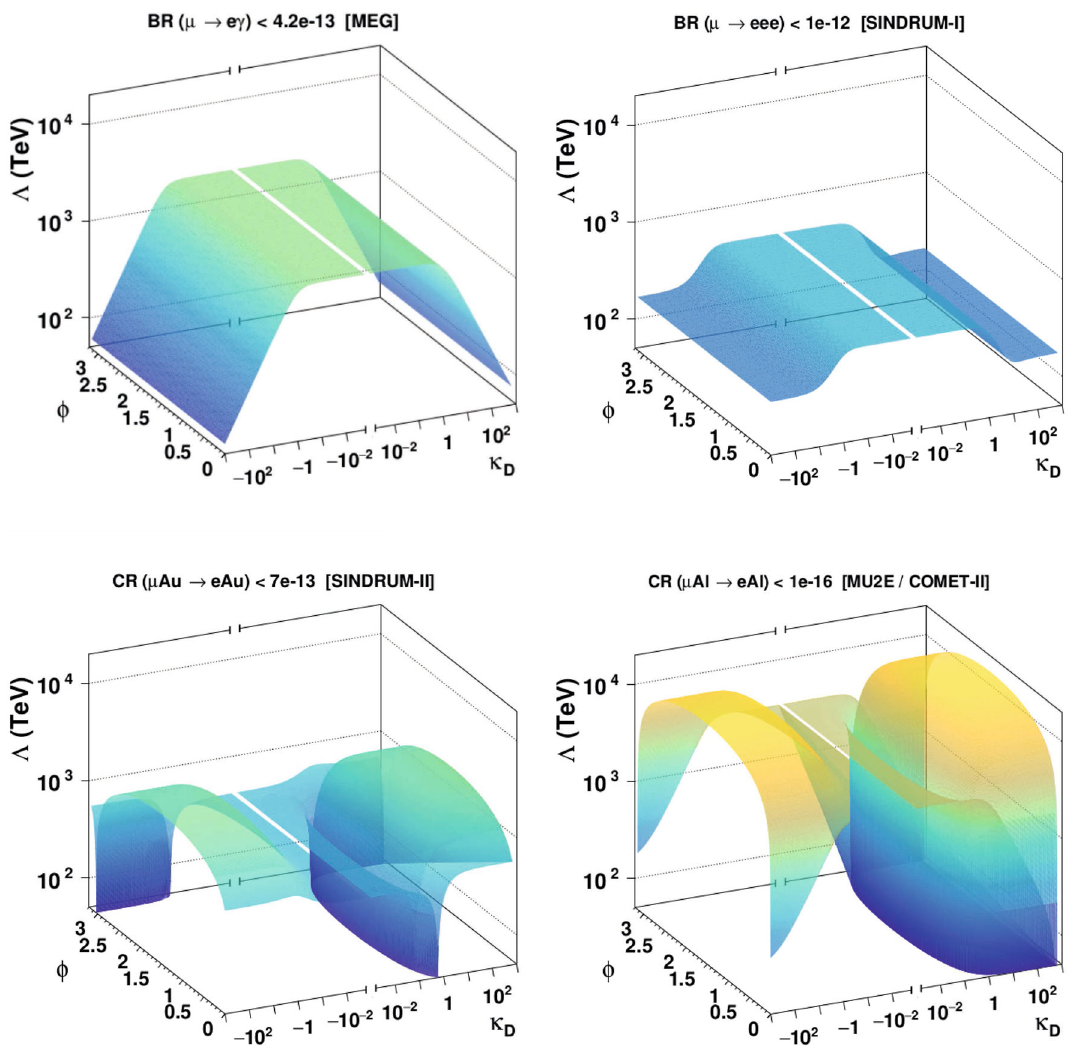
Fig. 4 Reach as a function of the angle φ and the variable κ D for θ V = π/ 4 and θ S = π/ 2. Note that φ runs from 0 → 2 π , although it is plotted from 0 → π ; the rates for φ ∈ (π → 2 π) with positive dipole are equal to those with negative dipole and φ ∈ ( 0 →